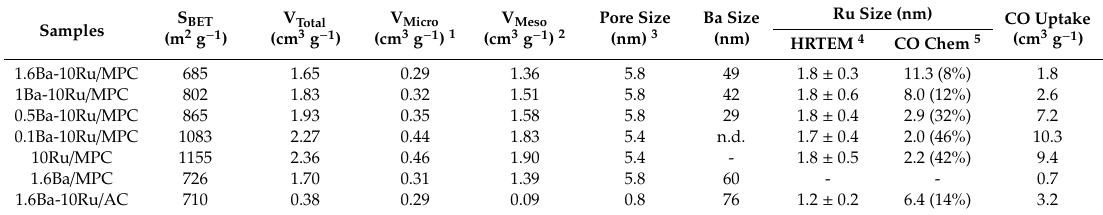
Table 1. The structural properties of the prepared Ba-Ru catalysts and reference materials.